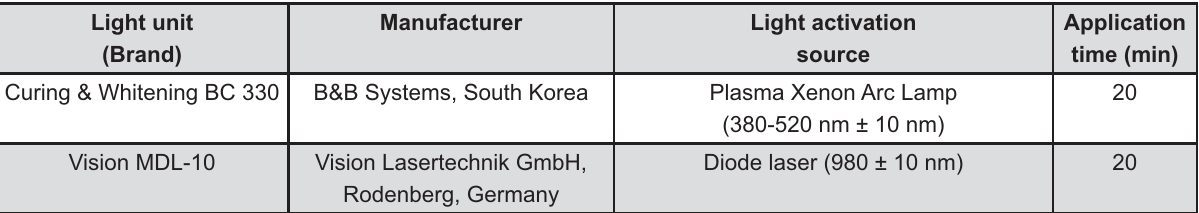
Figure 2- Light sources employed in this study